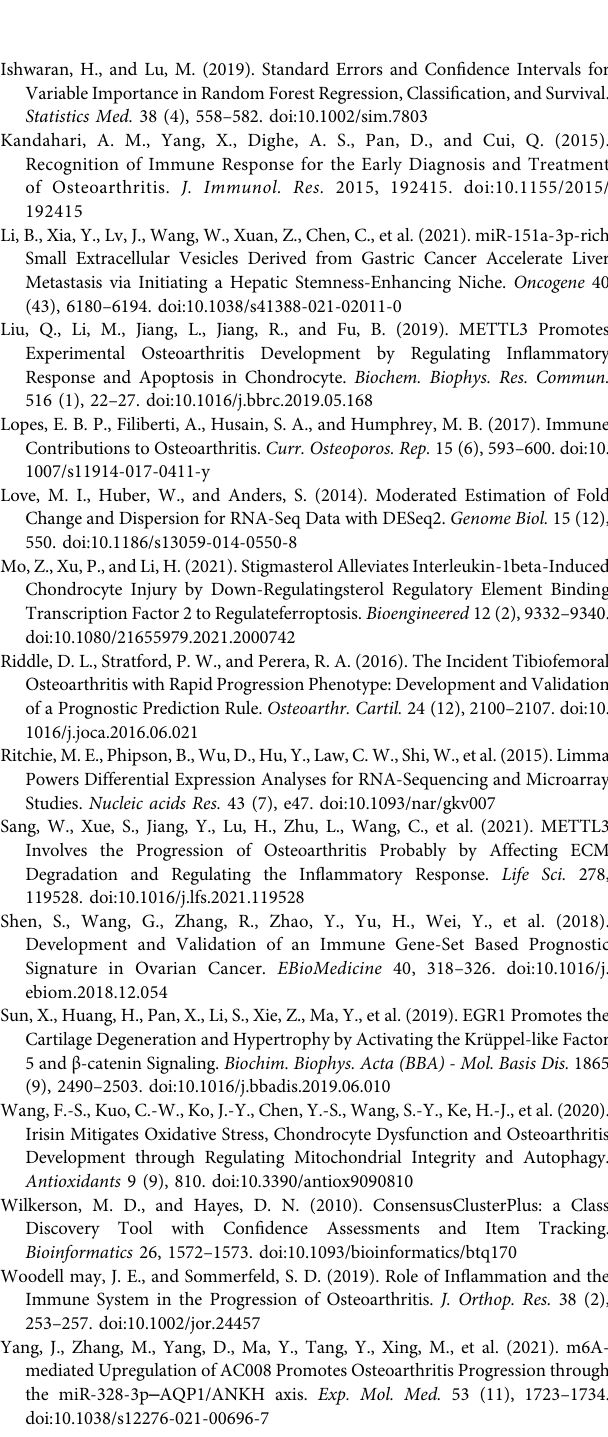
difference between the enrichment integrals of M6A modi fi cation mode 1 and mode 2 signaling pathways. (B) the difference between the enrichment integrals of M6A modi fi cation mode 1 and mode 3 signaling pathways. (C) M6A modi fi cation mode 2 and mode 3 signaling pathways Differences in enrichment scores. Supplementary Figure S3 | Network graph analysis of highly expressed m6A genes in OA. (A) The interaction network of YTHDF3 and IGF2BP3 with compounds. (B) The transcription factor and miRNA binding network of YTHDF3 and